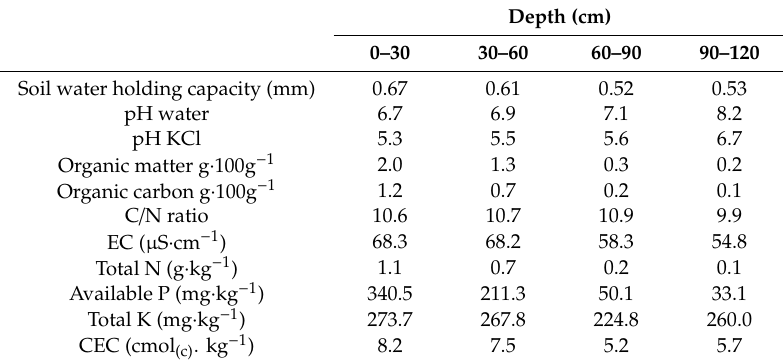
Table 8. Soil characteristics at the beginning of the experiment for all